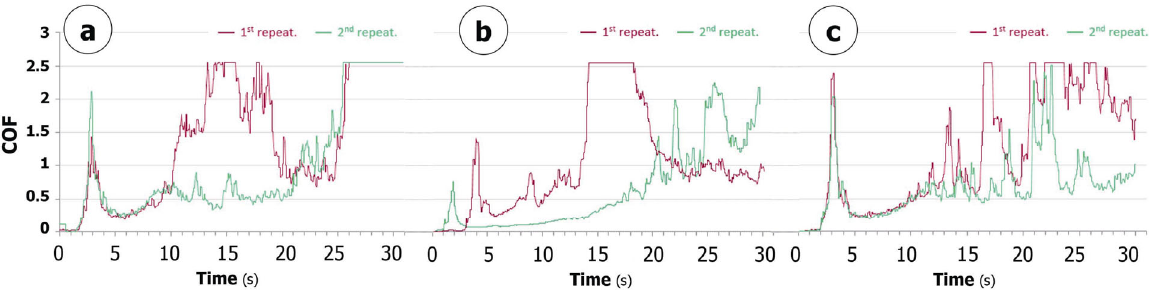
Fig. 9 Evolution of the COF during the polymer lubricated tribotests for the as-received (a) tool steel A, (b) tool steel V, and (c) tool steel O (load 10 N, stroke length 4 mm, frequency 12.5 Hz, temp. 300